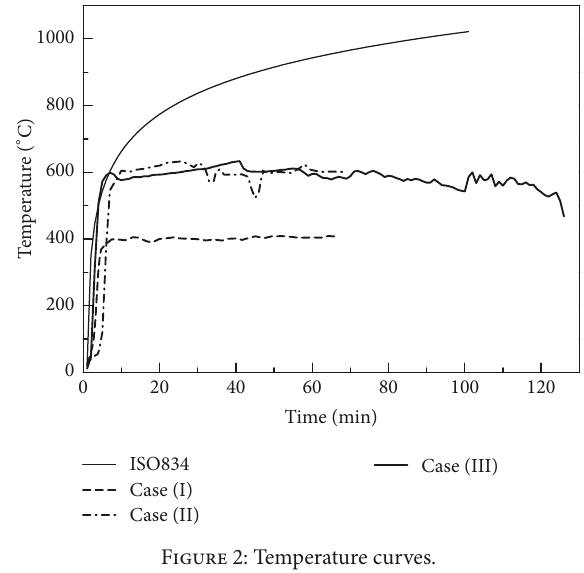
Figure 2: Temperature curves.